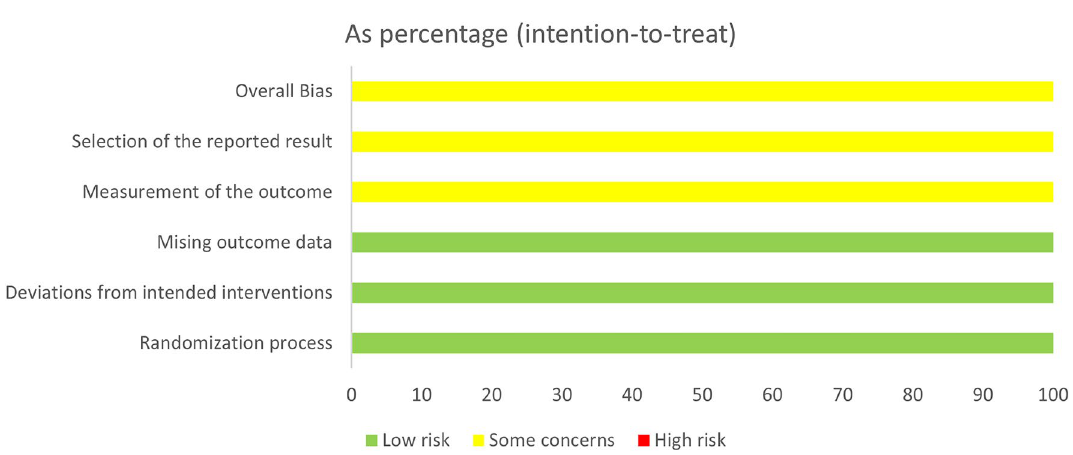
Figure 2. Risk of bias graph for randomized controlled trials using